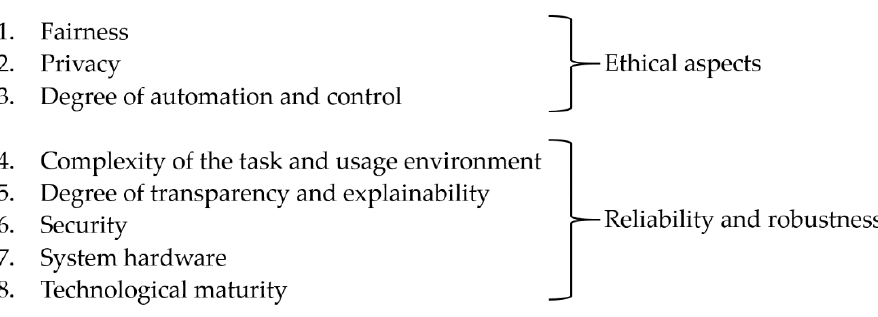
Figure 1. Sources of risk in AI systems that impact the trustworthiness of the system.